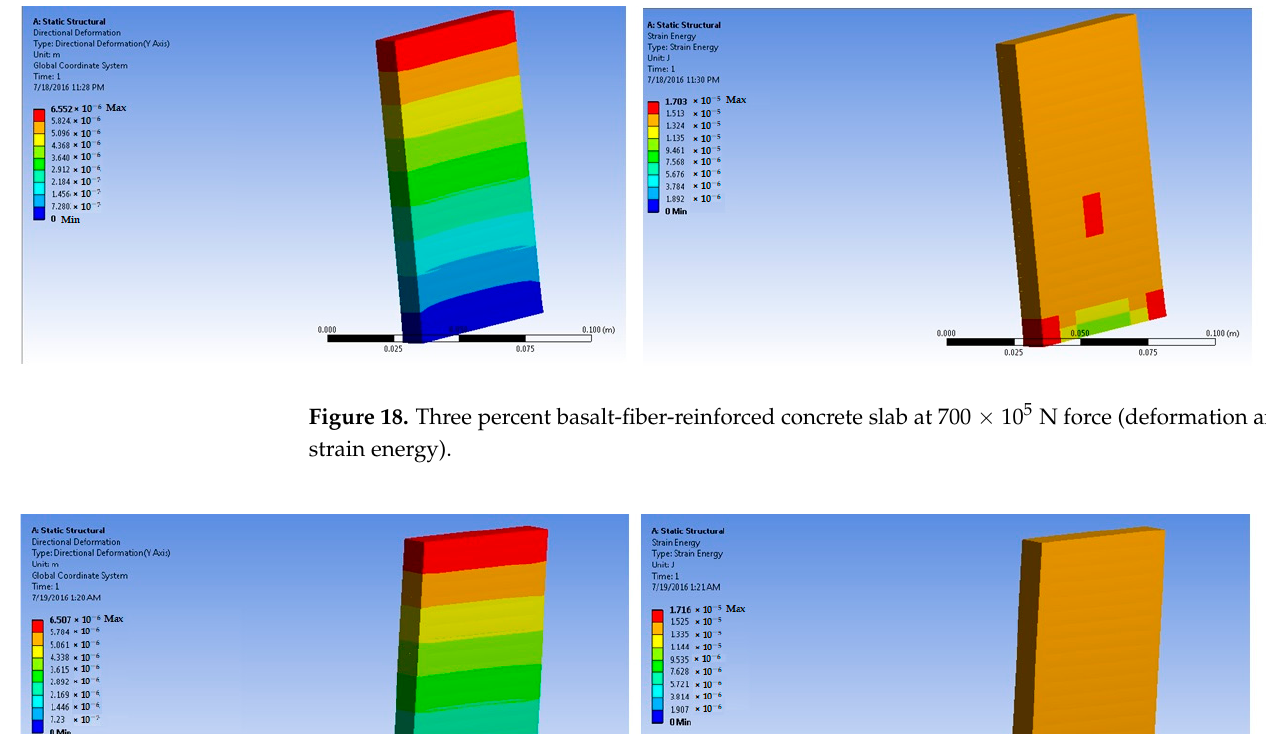
Figure 17. Three percent basalt-fiber-reinforced concrete slab at 50 × 10 5 N force (deformation and strain energy).